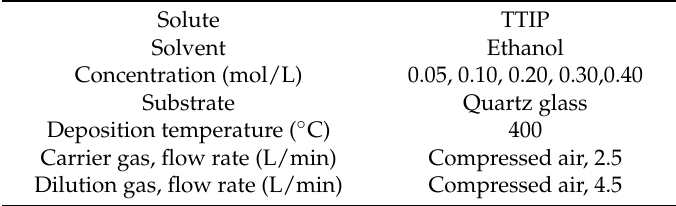
Table 2. Deposition condition of titanium tetraisopropoxide (TTIP) concentration